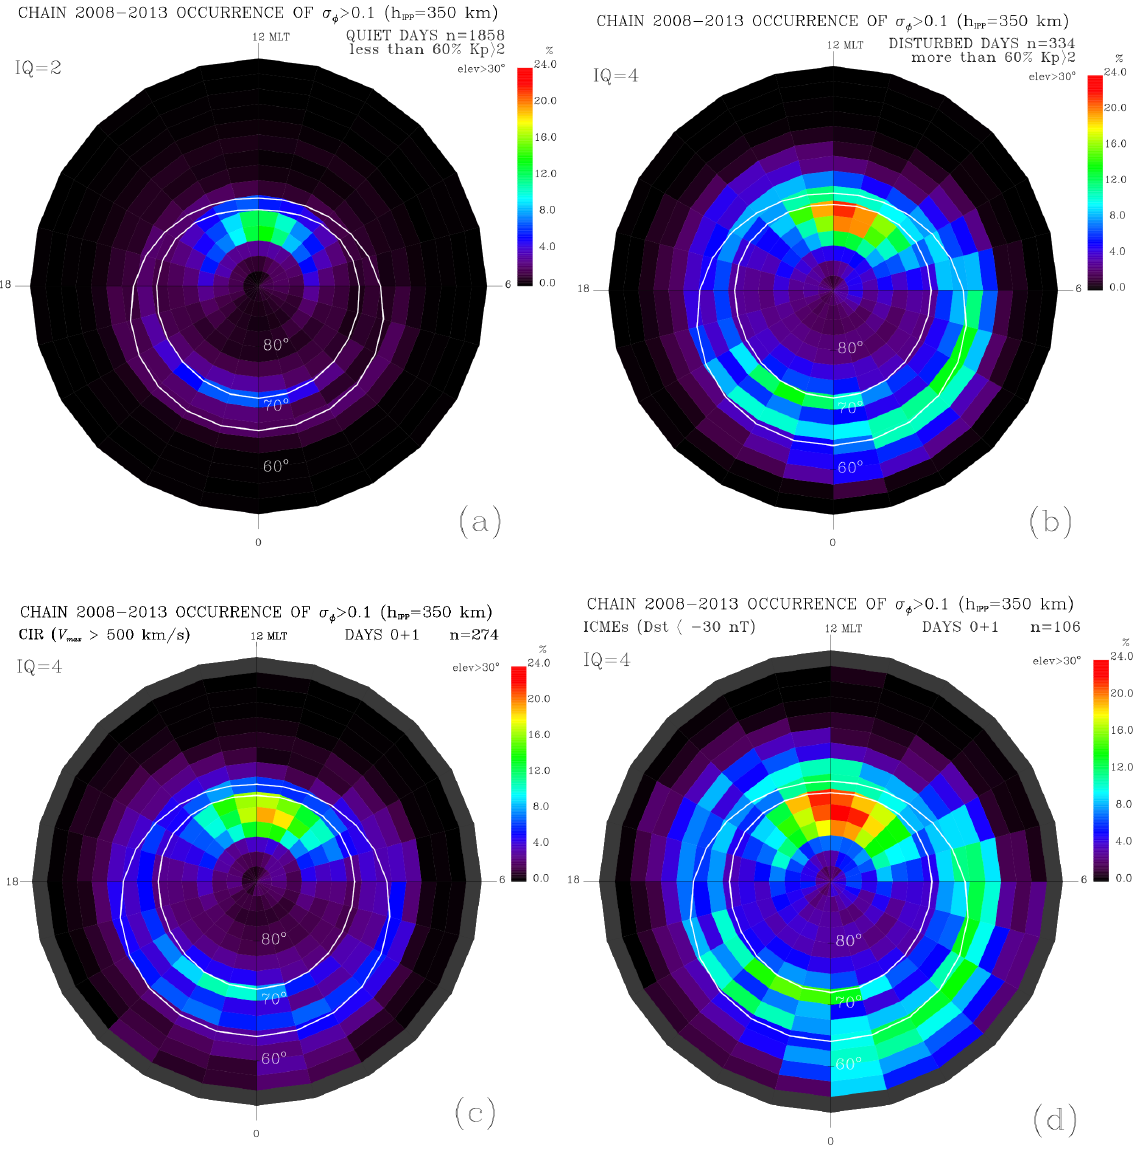
Figure 2. The 2008–2013 phase scintillation occurrence maps for geomagnetically (a) quiet and (b) disturbed days, and for (c) CIR/HSS and (d) ICME